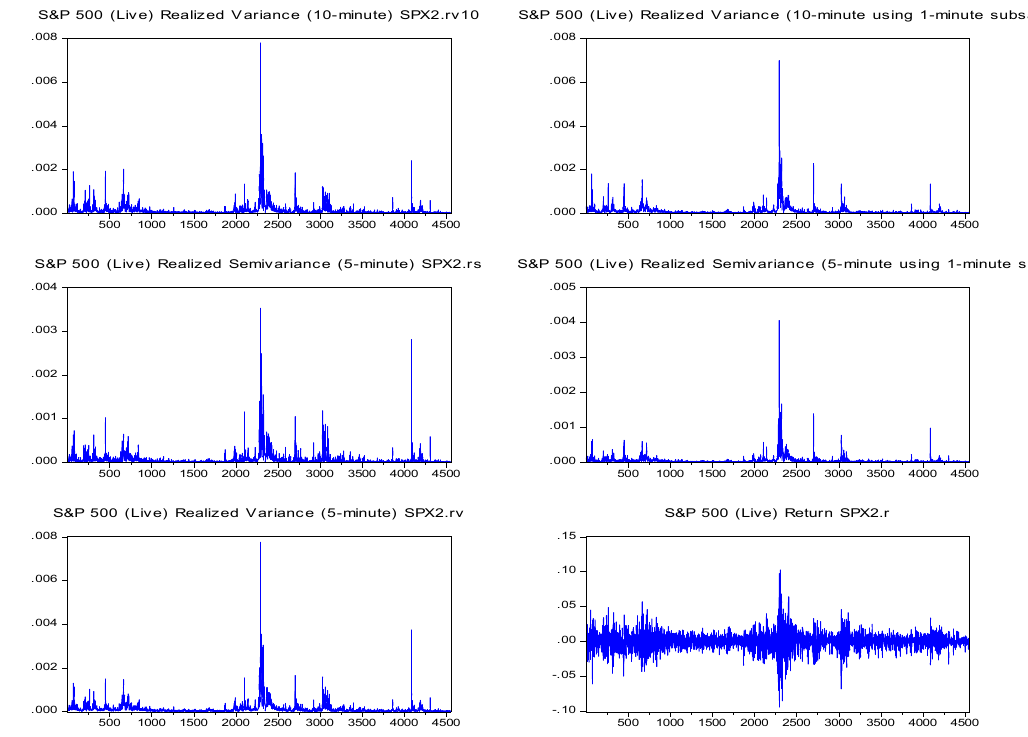
Figure 1. S&P500 plots. Note: This set of figures depict the realized measures on the S&P500 index (from left to right): The first figure depicts the realized bi-power variation (5-min sub-sampled) estimator, the second figure depicts the realized bi-power variation (5-min) estimator, the third figure depicts the S&P500 index closing price, the fourth figure depicts the median realized variance (5-min) estimator, the fifth figure depicts the realized Kernel variance estimator (two-scale/Barlett), the sixth figure depicts the realized variance (5-min sub-sampled) estimator, the seventh figure depicts the realized variance (10-min) estimator, the eighth figure depicts the realized variance (10-min sub-sampled) estimator, the ninth figure depicts the realized semi-variance (5-min) estimator, the tenth figure depicts the realized semi-variance (5-min sub-sampled) estimator, the eleventh figure depicts the realized variance (5-min) estimator, and the twelfth figure depicts the return on the S&P500 index.